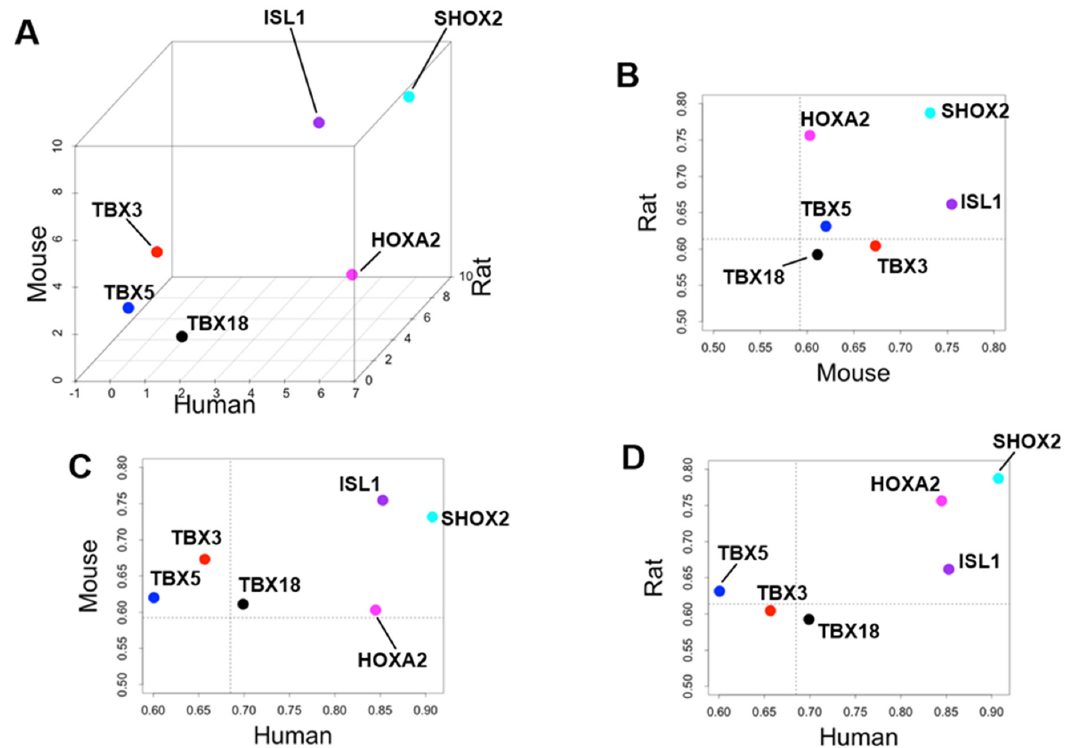
Figure 4. Specificity of six selected transcription factors with respect to sinoatrial nodes across three animal species. ( A ) Plot of z-score normalized specificity measure (SPM) values for three animal species: human on the x -axis, rat on the y -axis, and mouse on the z -axis. Scatter plots showing the relationship between ( B ) mouse–rat, ( C ) human–mouse, and ( D ) human–rat raw SPM values. The dotted lines indicate the threshold SPM values for specificity in this study. SHOX2 , HOXA2 , and ISL1 exceed the threshold values in all species. SHOX2 , HOXA2 , and ISL1 exceed the threshold values in all species.